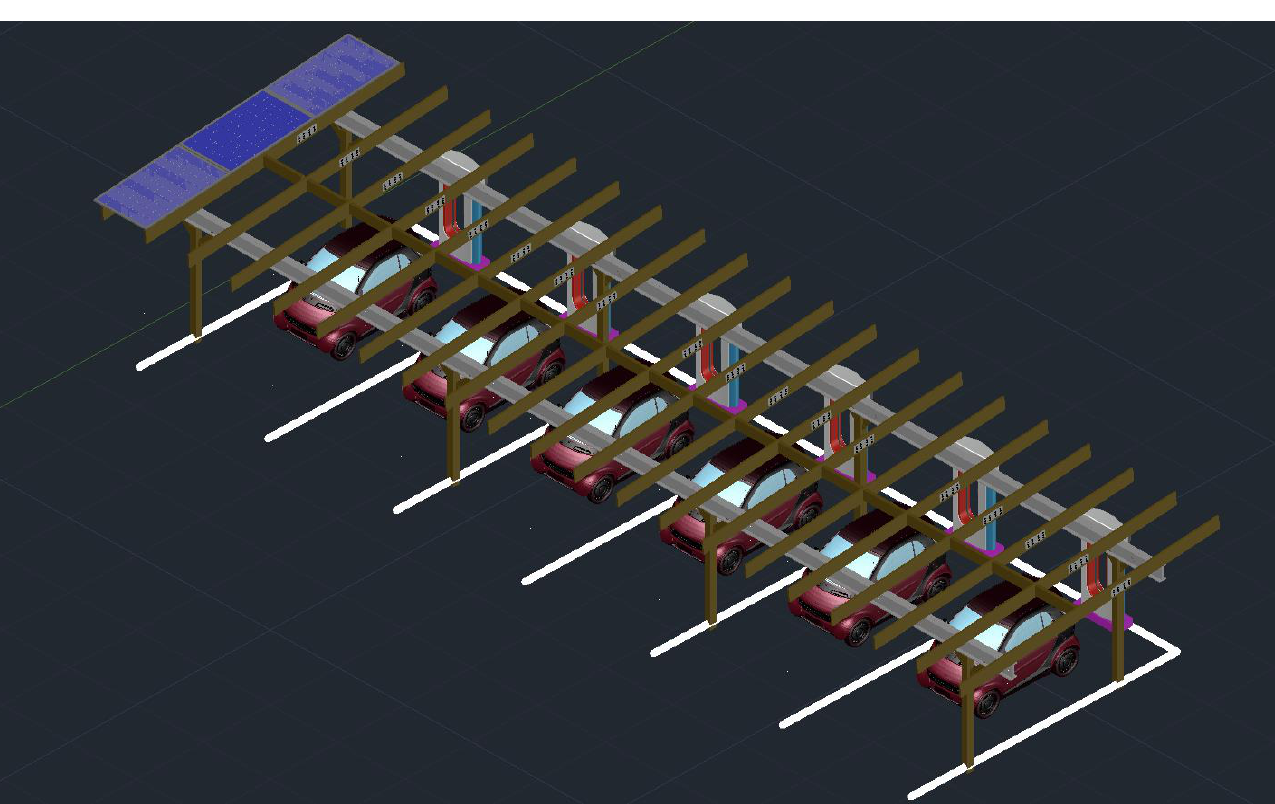
Figure 7. Completed Double Span System, constructed in the same way as the Single Span System, but with aluminum I beams being installed on top of the 6 × 6 posts with self-tapping screws.